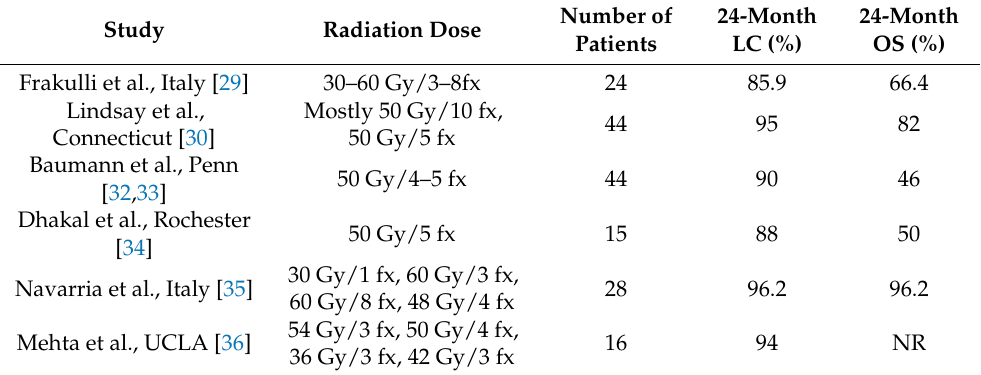
Table 1. SBRT for pulmonary metastasis in soft tissue